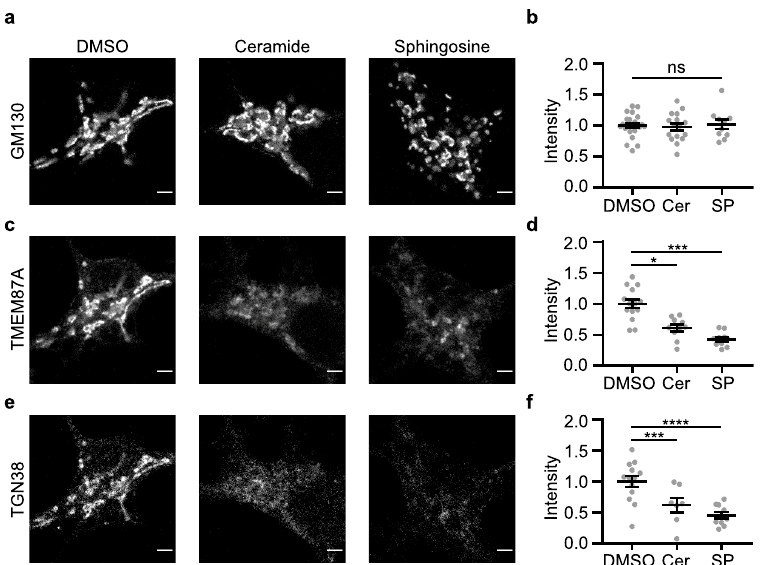
Figure 6. Addition of C6-Ceramide (Cer) or l-Erythro-Sphingosine (SP) to wildtype neurons does not affect staining intensity of cis- Golgi protein GM130, while TGN protein staining intensity is decreased. ( a ) Representative examples of neurons immunostained for GM130, after 4 h treatment with 0.1% DMSO, 20 μM C6-Ceramide or 8 μM l-Erythro-Sphingosine. ( b ) GM130 normalized staining intensity is not affected by C6-Ceramide or l-Erythro-Sphingosine treatment (DMSO: n = 22; Cer: n = 16; SP: n = 10). One-way ANOVA (ns, p = 0.8834). ( c ) Representative examples of neurons immunostained for TMEM87A, after 4 h treatment with 0.1% DMSO, 20 μM C6-Ceramide or 8 μM l-Erythro-Sphingosine. ( d ) TMEM87A normalized staining intensity is decreased after C6-Ceramide or l-Erythro-Sphingosine treatment (DMSO: n = 14; Cer: n = 10; SP: n = 10). One-way ANOVA with Tukey’s multiple comparisons test: DMSO vs Cer: ***p = 0.0002, DMSO vs SP: ****p < 0.0001, Cer vs SP: ns, p = 0.1312. ( e ) Representative examples of neurons immunostained for